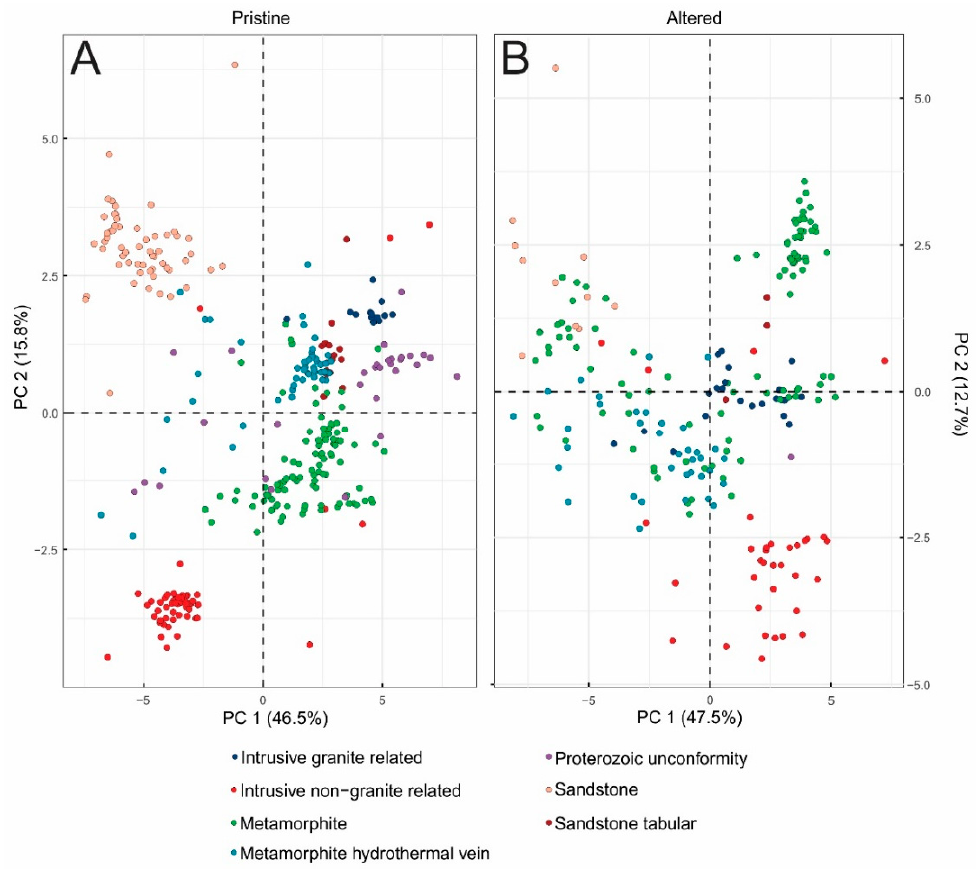
Figure 9. Principal component analysis for ( A ) pristine and ( B ) altered uraninite samples using major elements (wt. %; Table S1) and rare earth element abundances (ppm; Table S2). Two principal component analyses were conducted; therefore, the PC 1 and PC 2 are different vectors for both the pristine and altered PCA.